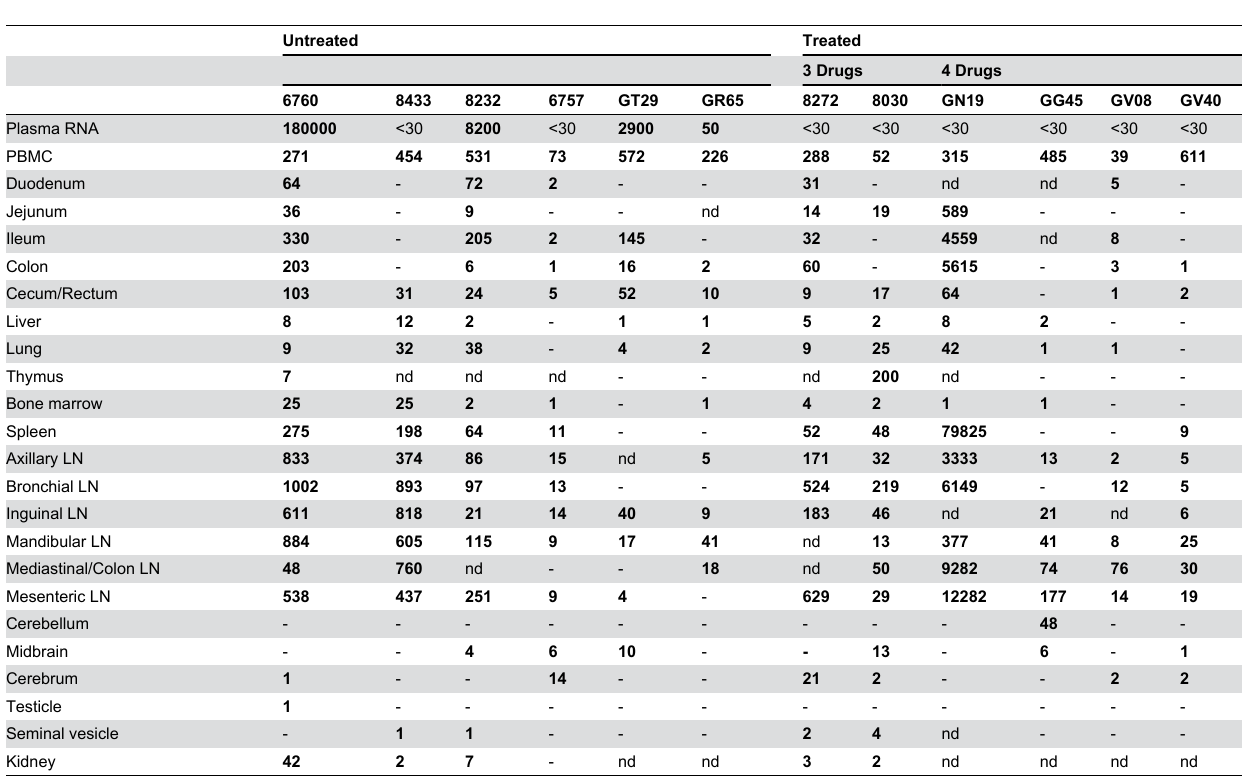
Table 1. gag DNA copies per 1x10 6 CCR5 DNA copies per tissue at necropsy (week 30/31).